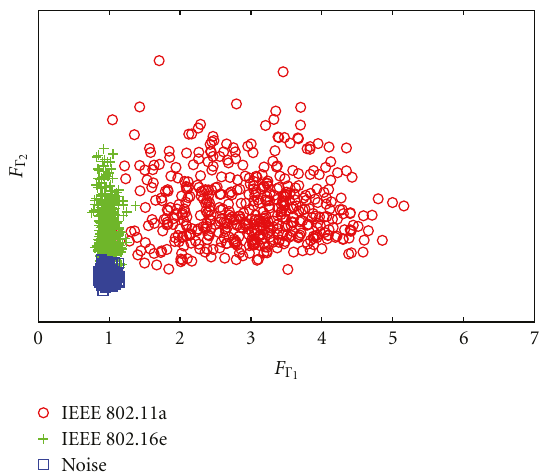
Figure 5: Plane of the features for an IEEE 802.11a signal, an IEEE 802.16e signal and no transmission (noise) with L = 500 and /N E = b 0